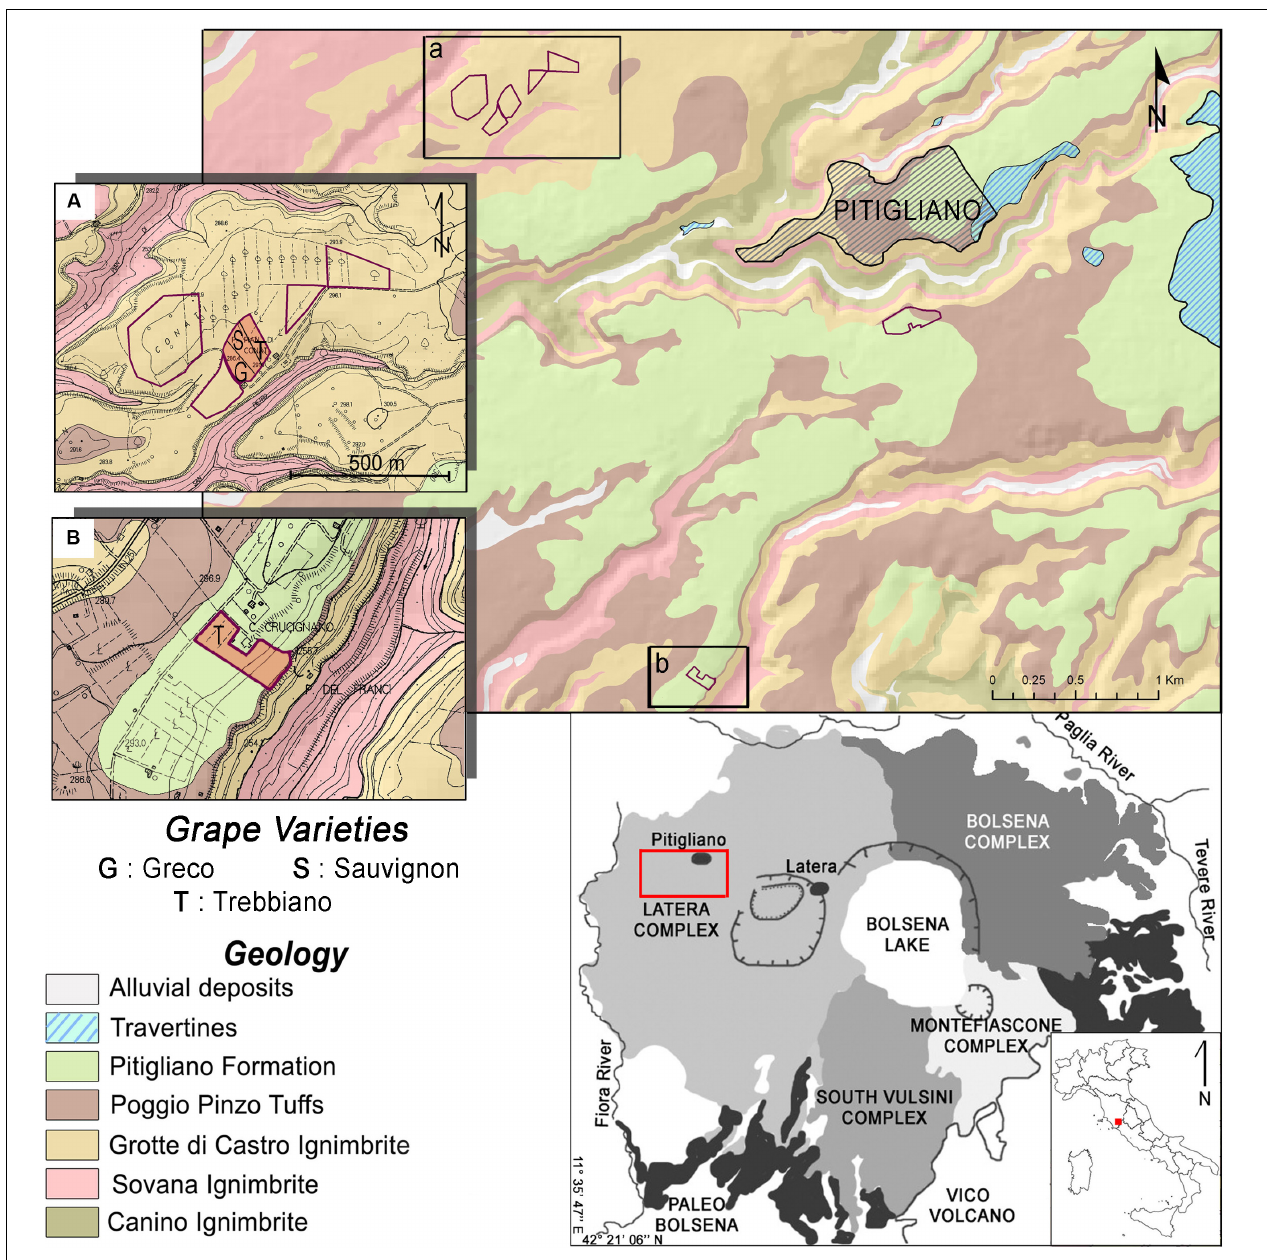
FIGURE 1 | Geological sketch map of the study area (redrawn after Tescione et al., 2018), with rocks belonging to the Latera volcano succession, the last erupting volcano of the Vulsini district (e.g., Conticelli et al., 2010). It is worth noting that the Pian de’ Conati vineyards fully developed within the Eutric Epileptic Andosols (IUSS, 2006) (autoct. Aia di Tufi soil; http://www.lamma.rete.toscana.it/territorio/cartografia-tematica/pedologia/carta-dei-suoli), which derive by the pedogenization of the Grotte di Castro formation (Vezzoli et al., 1987). On the other hand, the Crucignano vineyard developed within the Epileptic Andosols (IUSS, 2006) (autoc. Farmacista soil), which is derived from the pedogenization of the Pitigliano formation (Vezzoli et al., 1987). See also Supplementary Material